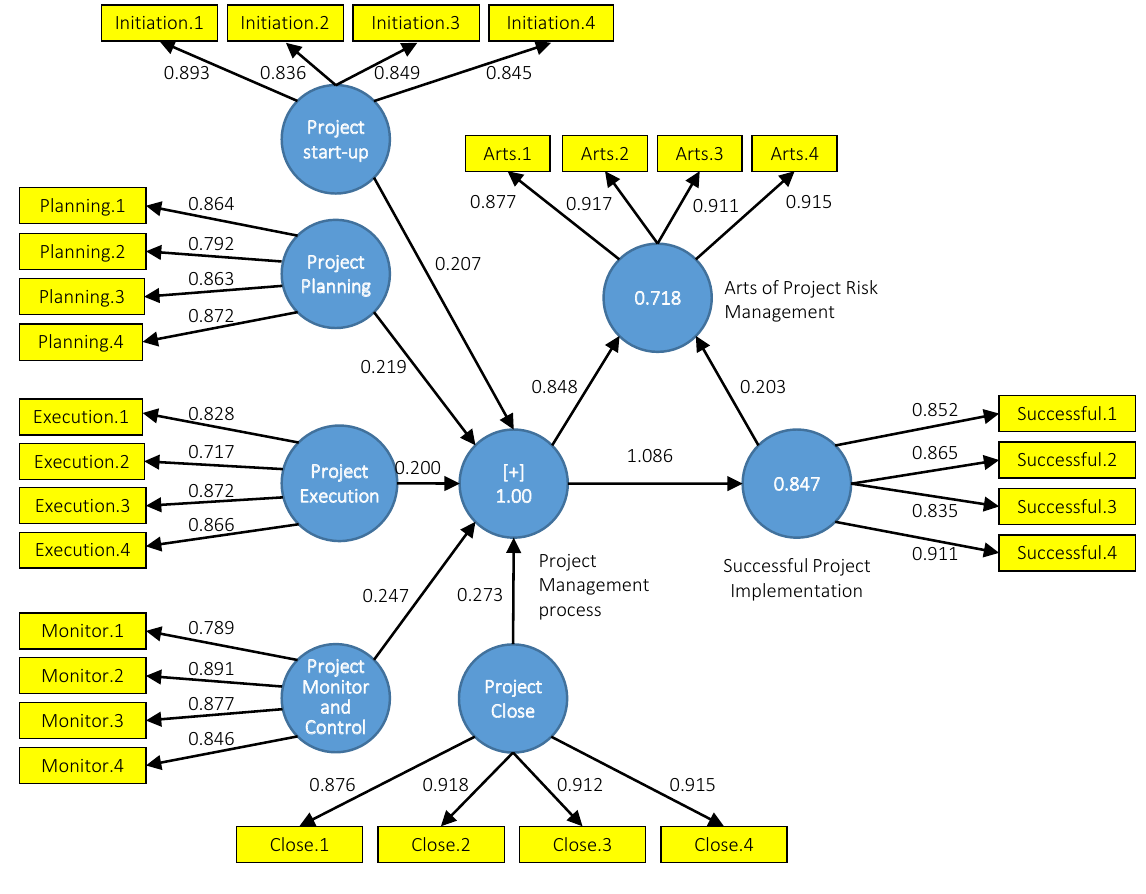
Figure 2. Factor analysis